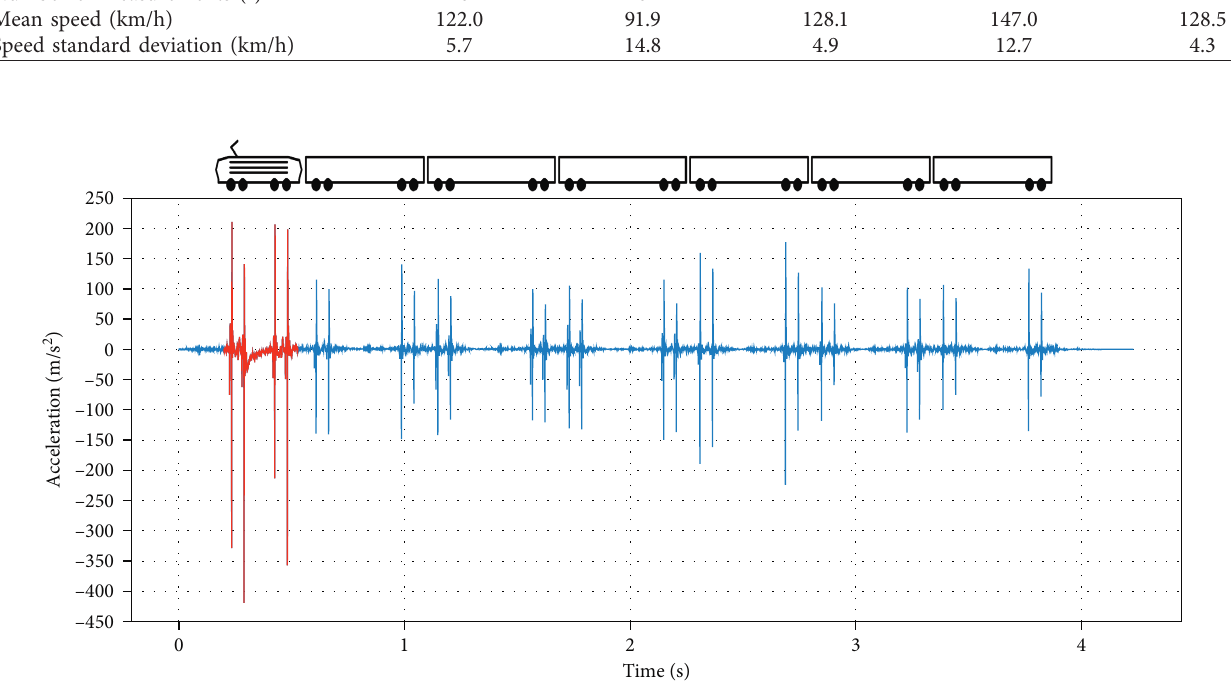
Figure 2: Accelerometer signal ( Z -axis) during train passage over a crossing. The locomotive part is highlighted in red and shown in detail in Figure 3.